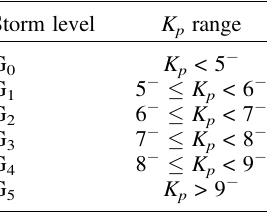
Table 1. Table showing different categories of geomagnetic storm and associated K p levels. The categorization is done based on the intensity of the geomagnetic storm following the NOAA SWPC